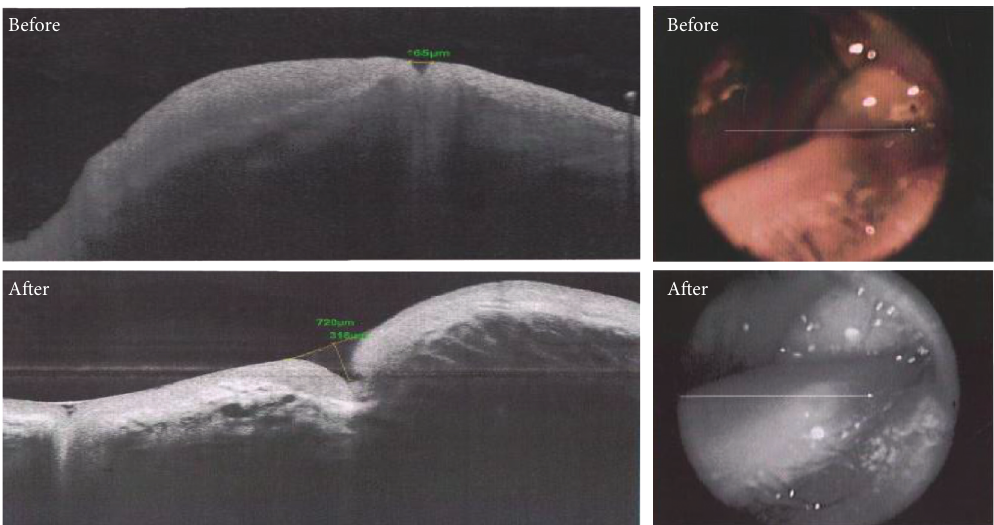
Figure 3: Case 2: OCT punctal changes before and after treatment.